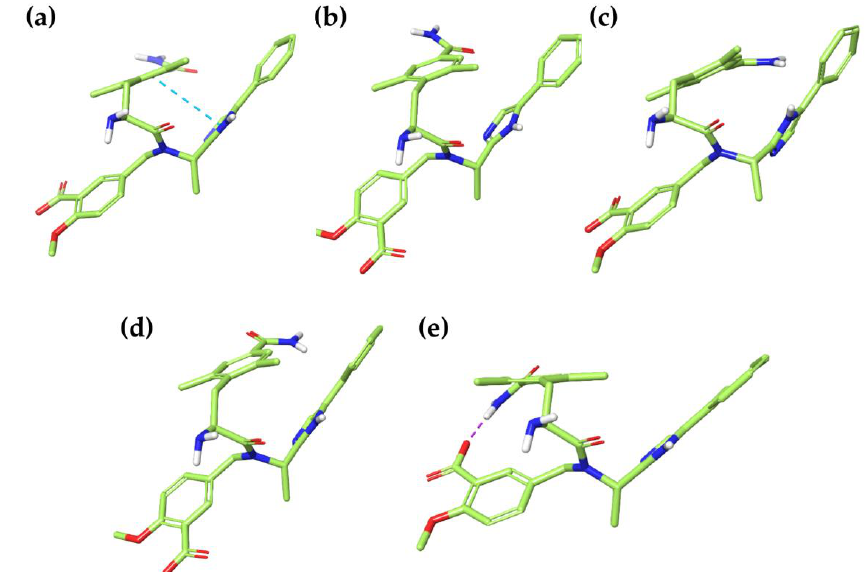
Figure 5. Three-dimensional structures of the best energy minima (%B > 10%) of E3, obtained after MD simulations conducted in both solvents. Intramolecular interactions are shown as cyan (π-π) and purple (H-bond) dash lines. ( a ) E3-MD1w , ( b ) E3-MD2w , ( c ) E3-MD3w , ( d ) E3-MD4w , and ( e ) E1-MD1o .